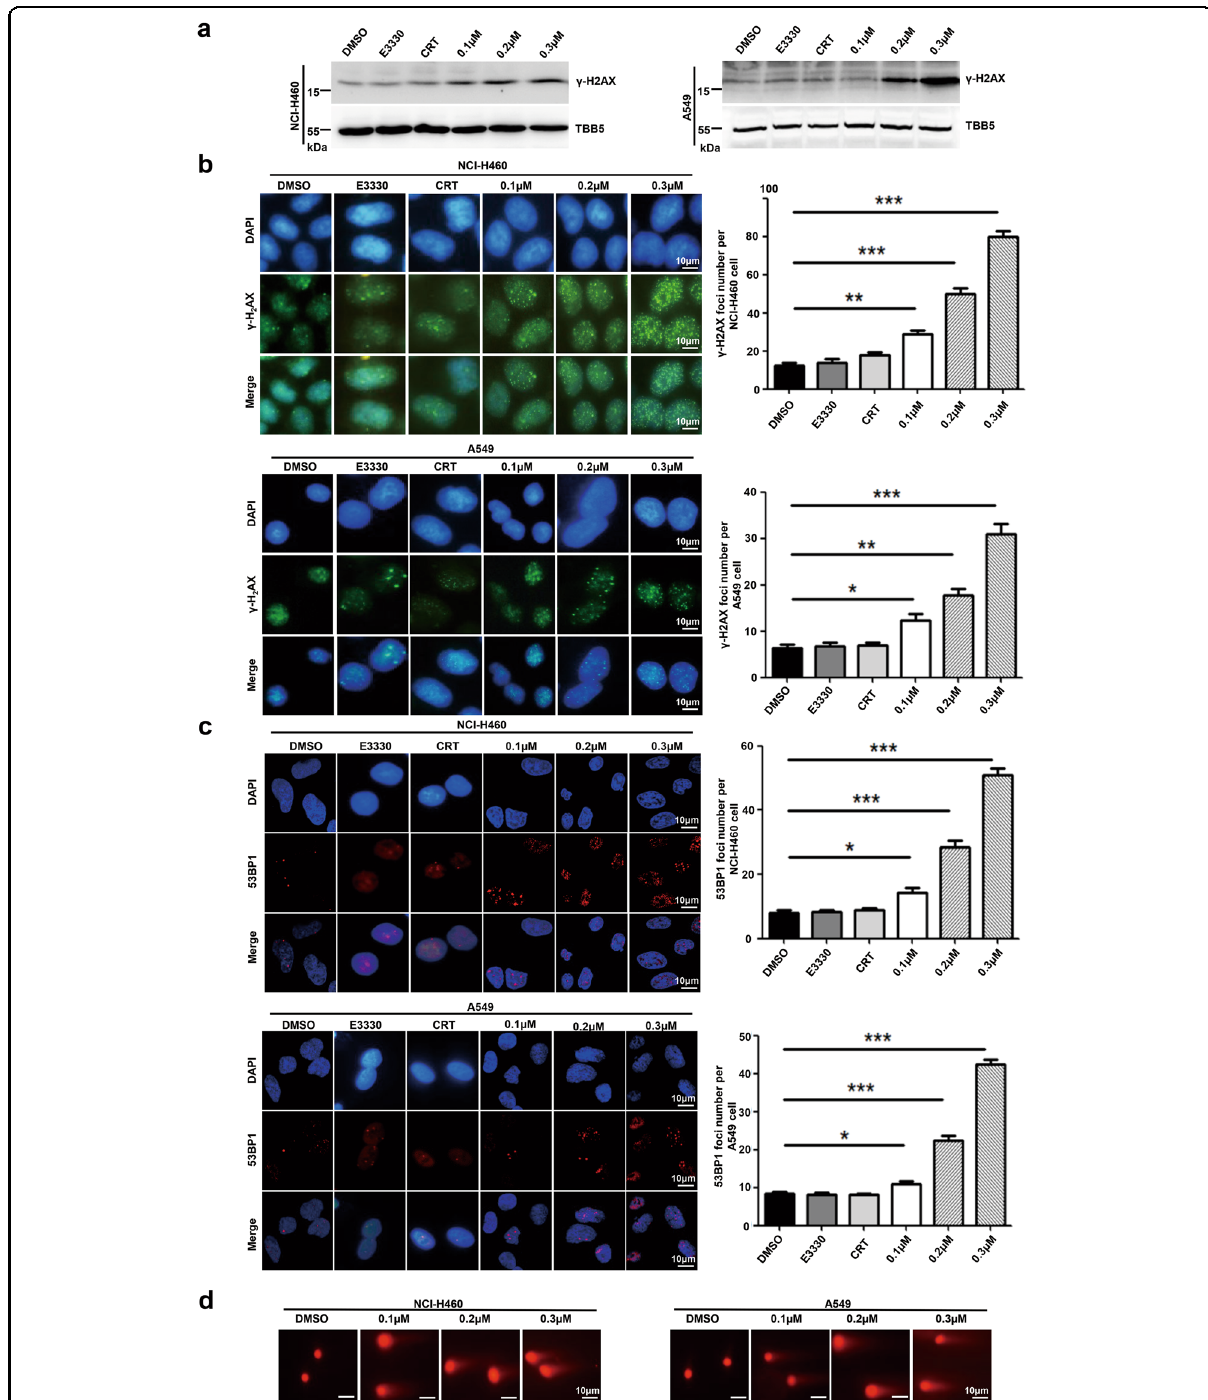
Fig. 3 Inhibition of FEN1 by NO.0449-0145 leads to the accumulation of DNA damage. a Western blot assay to determine γ -H2AX levels in A549 and NCI-H460 cells following different dose of NO.0449-0145 treatments. b , c Immuno fl uorescence staining of γ -H2AX foci and 53BP1 foci in cells. The quanti fi cation of the foci numbers per cells were showed in right panel. d Comet assay of A549 and NCI-H460 cells treated with or without NO.0449-0145. Representative images for the quanti fi cation of the average tail moment reported for each treatment condition. Each experiment was repeated three times. * p < 0.05; ** p < 0.01; *** p <